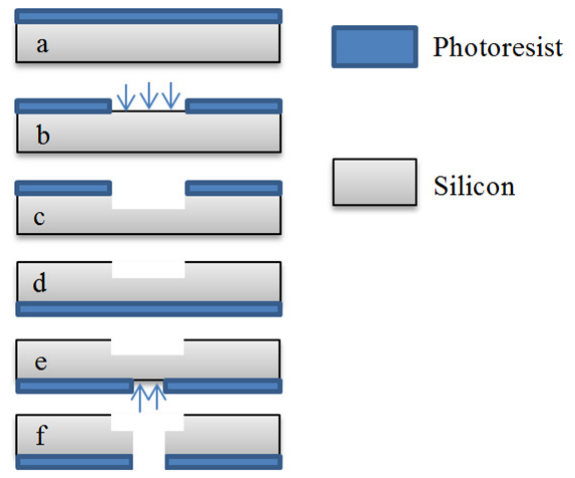
Figure 7. Schematic view of the current fabrication process (P1) for the StarJet nozzle chips (cross-section view).